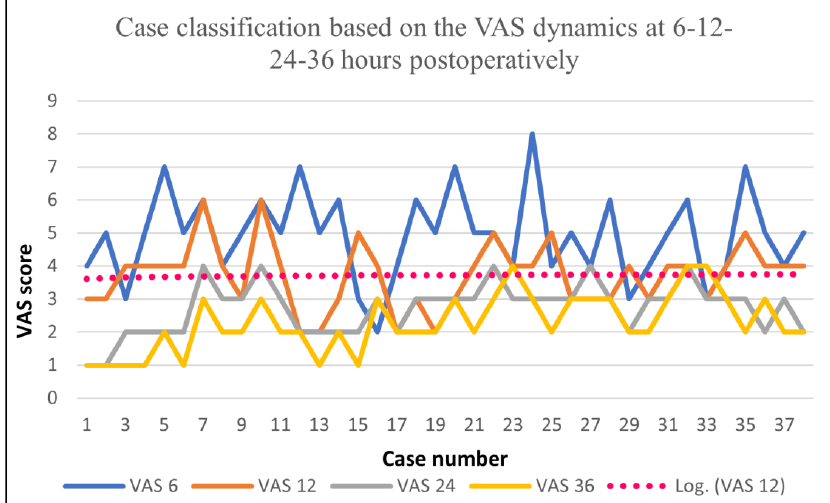
Figure 3. VAS dynamics for Group B.